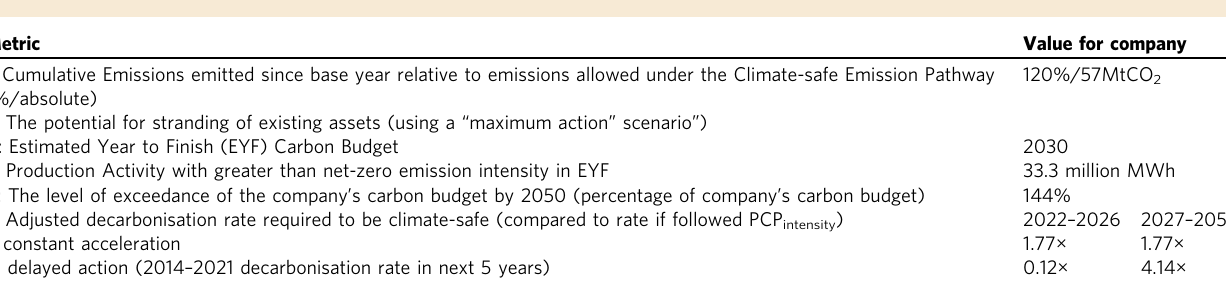
Table 2 Calculated transition performance metrics for company in Fig.